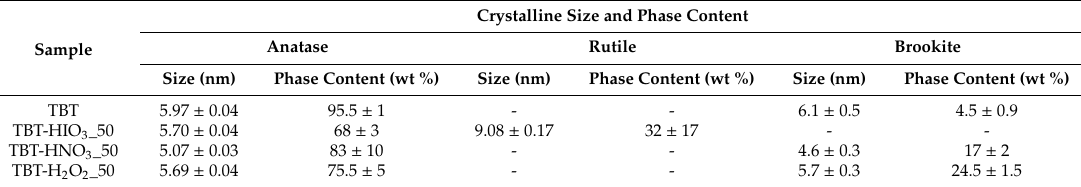
Figure 1. XRD patterns for defective TiO 2 photocatalysts (A—anatase, B—brookite, and R—rutile). Table 3. Crystalline phases characteristic for obtained defective TiO 2 .